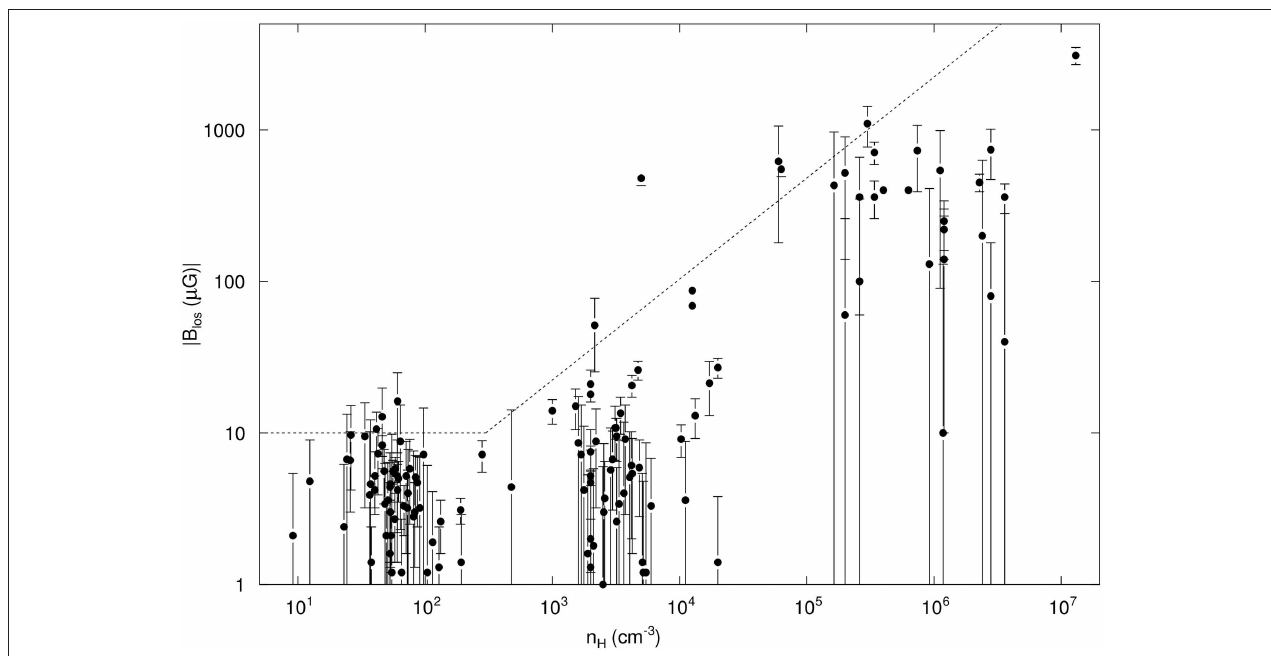
FIGURE 5 | The set of diffuse cloud and molecular cloud Zeeman measurements of the magnitude of the line-of-sight component B LOS of the magnetic vector B and their 1 σ uncertainties, plotted against n H = n ( H I ) or 2 n ( H 2 ) for H I and molecular clouds, respectively. Different symbols denote the nature of the cloud and source of the measurement: H I diffuse clouds, filled circles (Heiles and Troland, 2004); dark clouds, open circles (Troland and Crutcher, 2008); dark clouds, open squares (Crutcher, 1999), molecular clouds, filled squares (Crutcher, 1999); and molecular clouds, stars (Falgarone et al., 2008). Although Zeeman measurements give the direction of the line-of-sight component as well as the magnitude, only the magnitudes are plotted. The dotted line shows the most probable maximum values for B TOT ( n H ) determined from the plotted values of B LOS by the Bayesian analysis of Crutcher et al. (2010b).